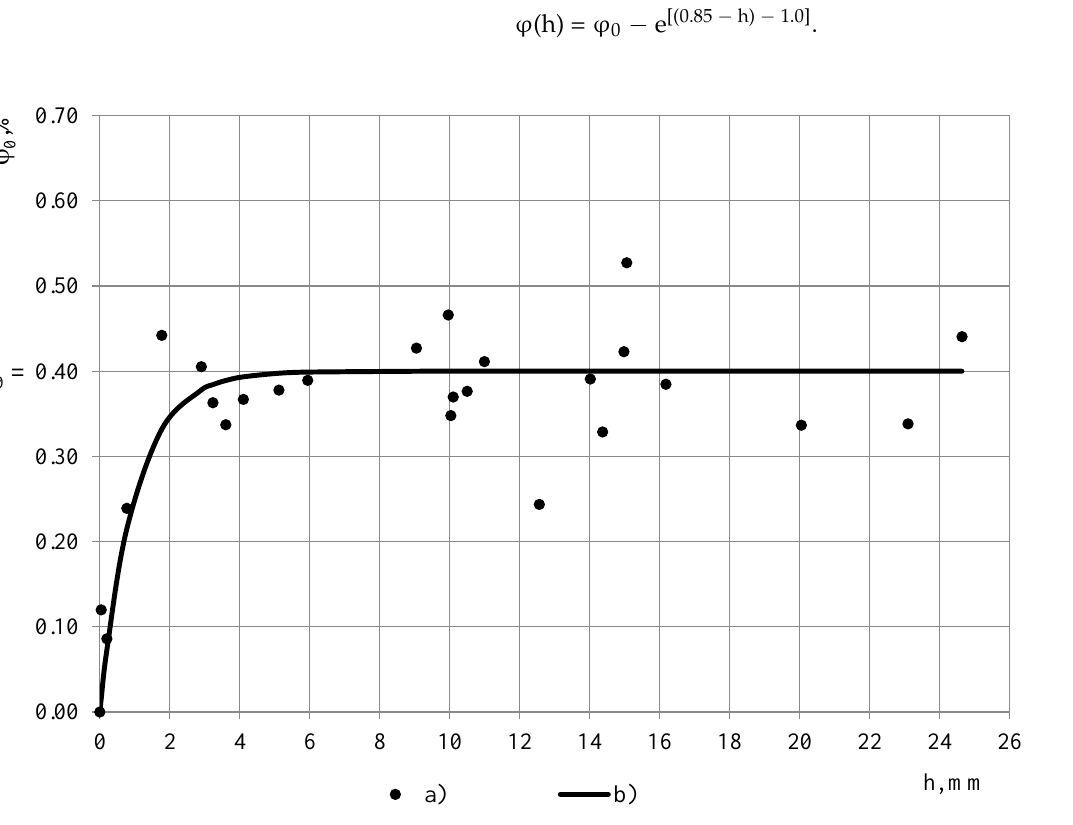
Figure 5. Dropping in dependence of PTFE sample’s thickness: (a) Experimental data and (b) model function.